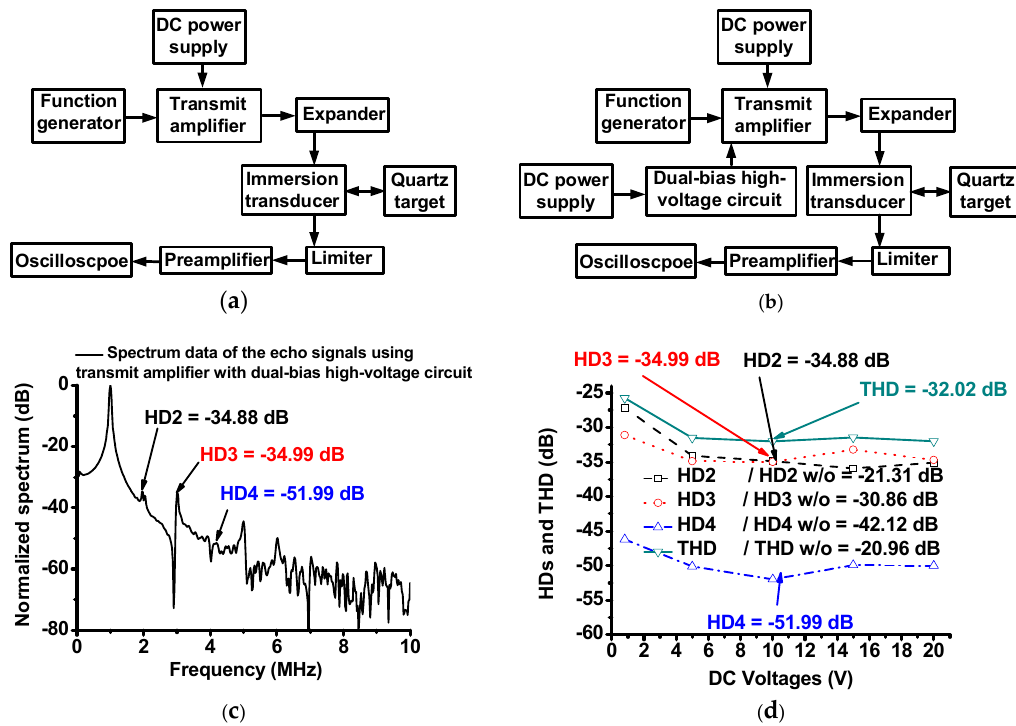
Figure 7. Block diagram of pulse-echo test measurement system when using ( a ) transmit amplifier only and ( b ) transmit amplifier with dual-bias high-voltage circuit, ( c ) spectrum data of echo signal generated by a 1 MHz immersion ultrasound transducer with transmit amplifier with dual-bias high-voltage circuit at 10 V DC bias voltage, and ( d ) HD2, HD3, HD4 and THD values with and without dual-bias high-voltage linearizer vs. 0.8 V, 5 V, 10 V, 15 V and 20 V DC bias voltages (graph with dash, dot, dash-dot and solid mark represent HD2, HD3, HD4, and THD of the transmit amplifier with dual-bias high-voltage circuit, respectively). HD2 w/o, HD3 w/o, HD4 w/o, THD w/o represent the measured HD2, HD3, HD4, and THD of the echo signals when using transmit amplifier only, respectively.